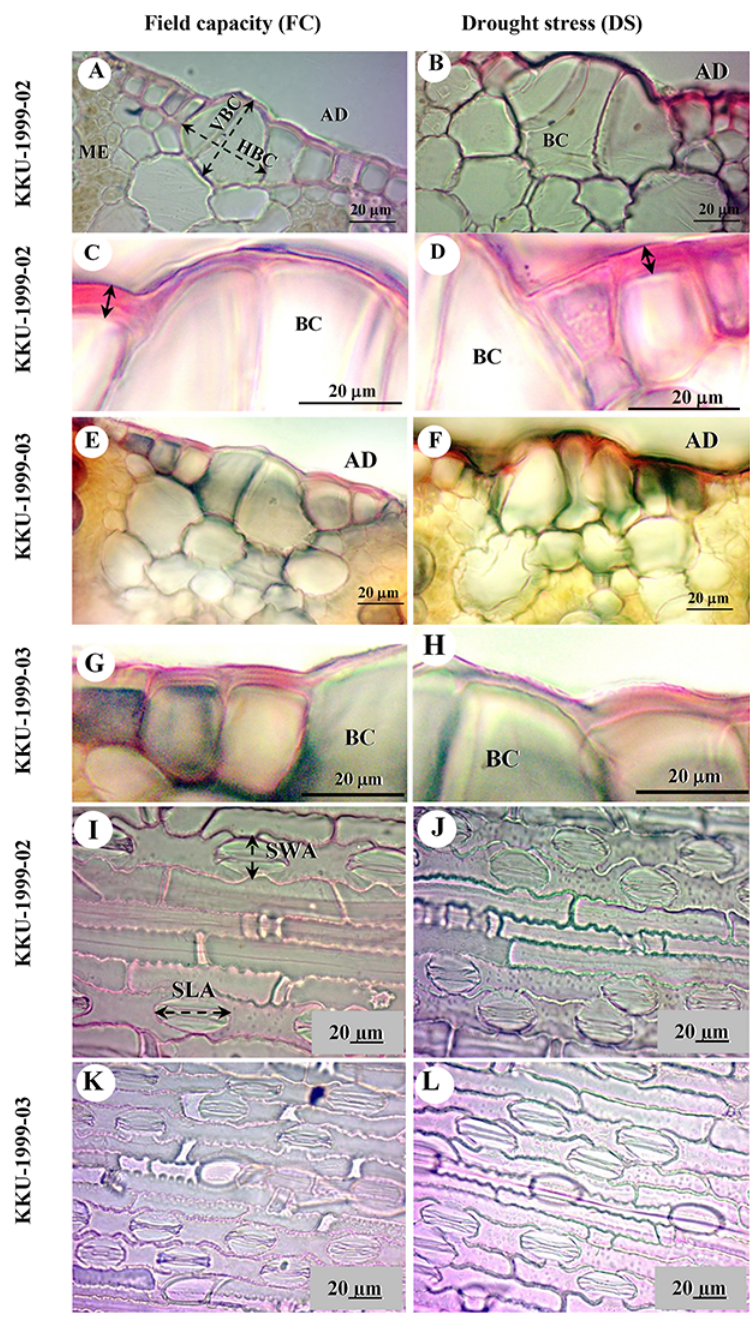
Figure 1 Sugarcane leaf transverse (leaf margin) ( A–H ) and epidermal peels ( I–L ) sections (lamina) of KKU-1999-02 ( A–D,I,J ) and KKU-1999-03 ( E–H,K,L ) cultivars for field capacity (FC) and drought stress (DS) treatments from 30 to 90 days. ( A,B,E,F ) Adaxial epidermis showing bulliform cells (BC); in ( A ): vertical length (VBC) and horizontal length (HBC) of bulliform cells. ( C,D,G,H ) Epidermal cell wall thickness (arrows). ( I–L ) Abaxial stomata and epidermal cell with FC ( I,K ) and DS ( J,L ); in ( I ): stomatal width of adaxial side (SWA) and stomatal length of adaxial side (SLA).